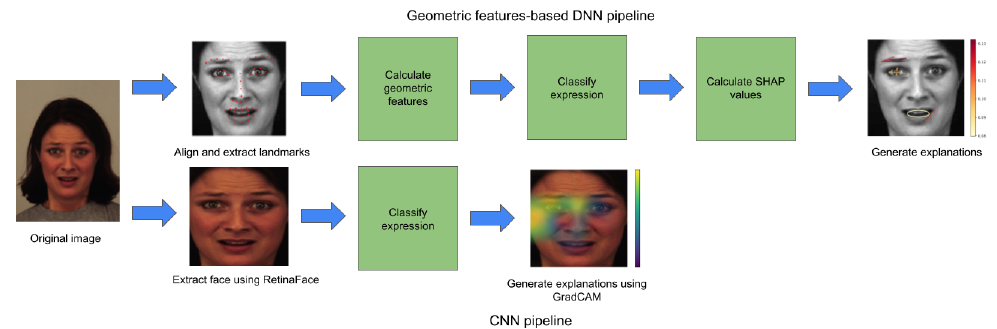
Figure 1. The two constructed pipelines. The top pipeline illustrates the process of the geometric features-based DNN and the bottom one illustrates the CNN process. The example image used in the pipeline is AF01AFS from the KDEF